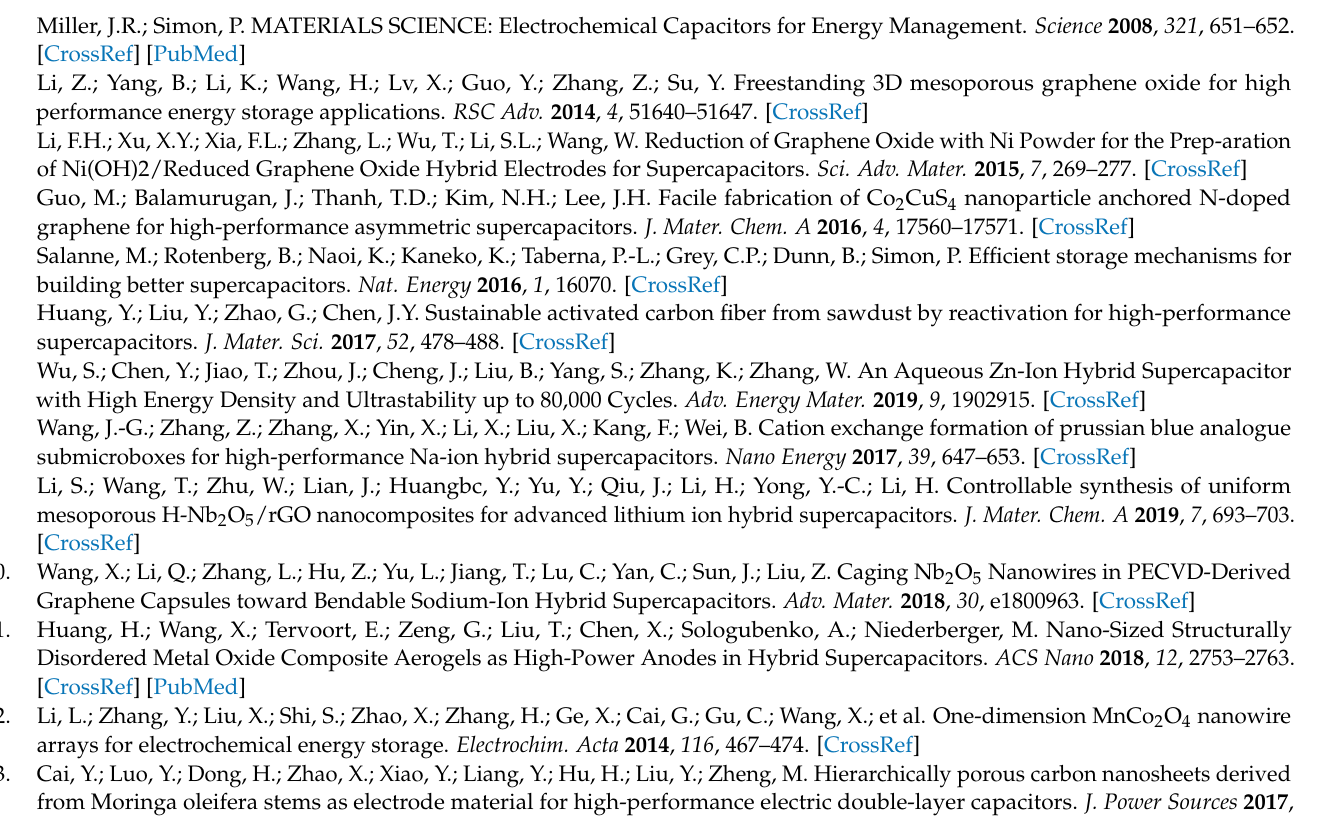
1/11/1/155/s1, Figure S1: The comparison of (a) N2 adsorption-desorption isotherms and (b) pore size distributions of LSNO-x samples at 77 K. Figure S2: The comparison of TG curves of other LSNO- x samples. Figure S3: High-resolution TEM (HRTEM) of LaNiO 3 sample. Figure S4: ( a – d ) Cyclic voltammetry (CV) curves of the LSNO-0, LSNO-0.1, LSNO-0.2 and LSNO-0.6 electrodes at different scan rates ranging from 5 to 50 mV s − 1 . Figure S5: ( a ) CV curves, ( b ) GCD curves, ( c ) Nyqusit plots and ( d ) Cycling performance of the prepared activated carbon (AC) electrode in 6 M KOH electrolyte. Figure S6: CV curves at different potential window ranging from 0–1 V to 0–1.7 V at a scan rate of 30 mV s − 1 . Table S1: Textural parameters of the LSNO-x samples. Table S2: Comparison of capacitive performance based on ABO 3 -based electrode materials in the